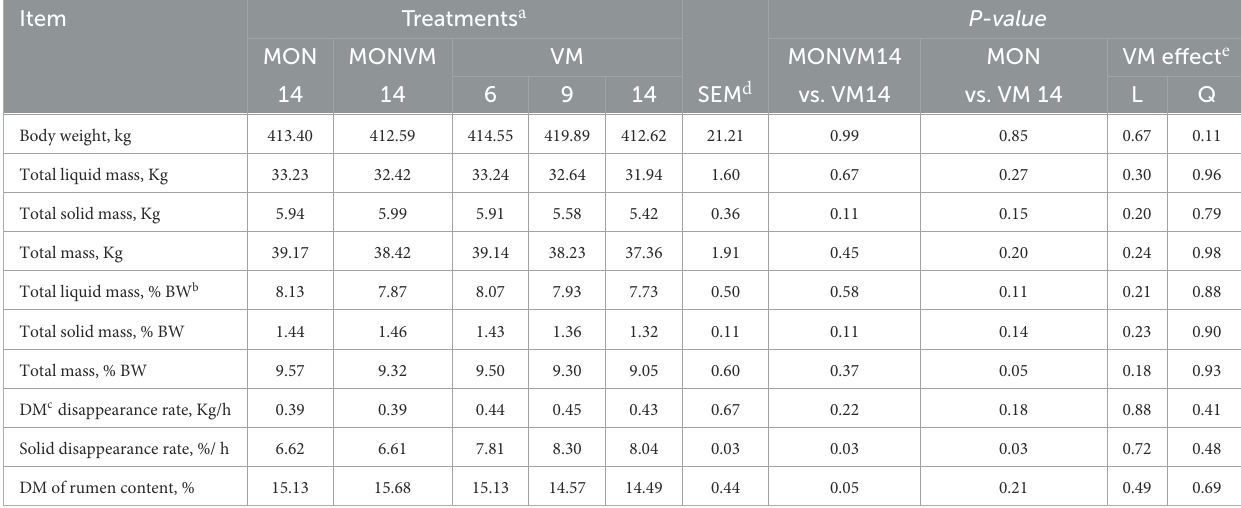
a MON14: 27mg of MON/kg of DM and adaption for 14 d; MON + VM14: 27mg of MON/kg of DM and 25mg of VM/kg of DM and adaption for 14 d; VM14: 25mg of VM/kg of DM and adaption for 14 d; VM9: 25mg of VM/kg of DM and adaption for 9 d; VM6: 25mg of VM/kg of DM and adaption for 6 d; b Body weight, c Dry matter; d Standard Error of Mean; e L: linear